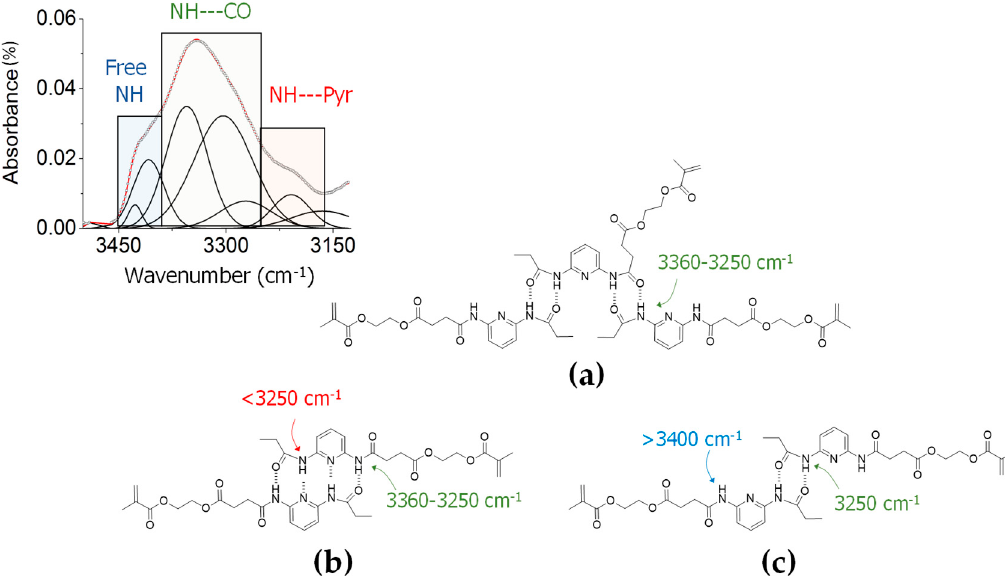
Figure 5. Schematic representations of different DAP supramolecular assemblies, including the N-H st. IR sub-regions for free N-H groups and those involved in hydrogen bonds with C=O groups and pyridine rings (Pyr): ( a ) DAP3-2HB-as, ( b ) DAP2-4HB-sym and ( c ) DAP2-2HB-sym.